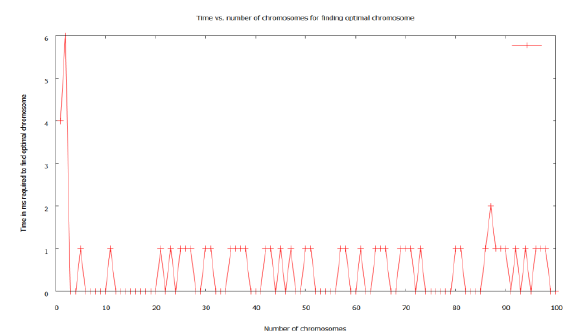
Figure 10. Diagram for representing simulation results of GA to find an optimal multicast tree